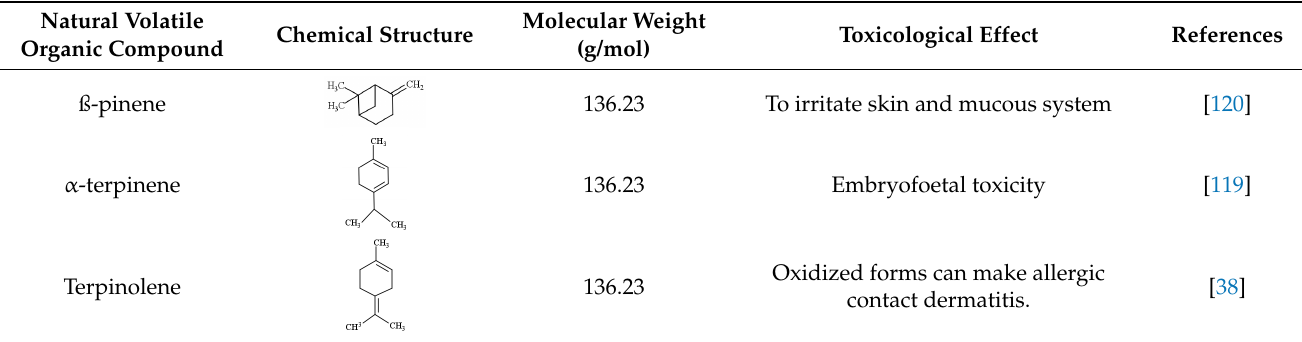
Oxidized forms can make allergic 136.23 contact